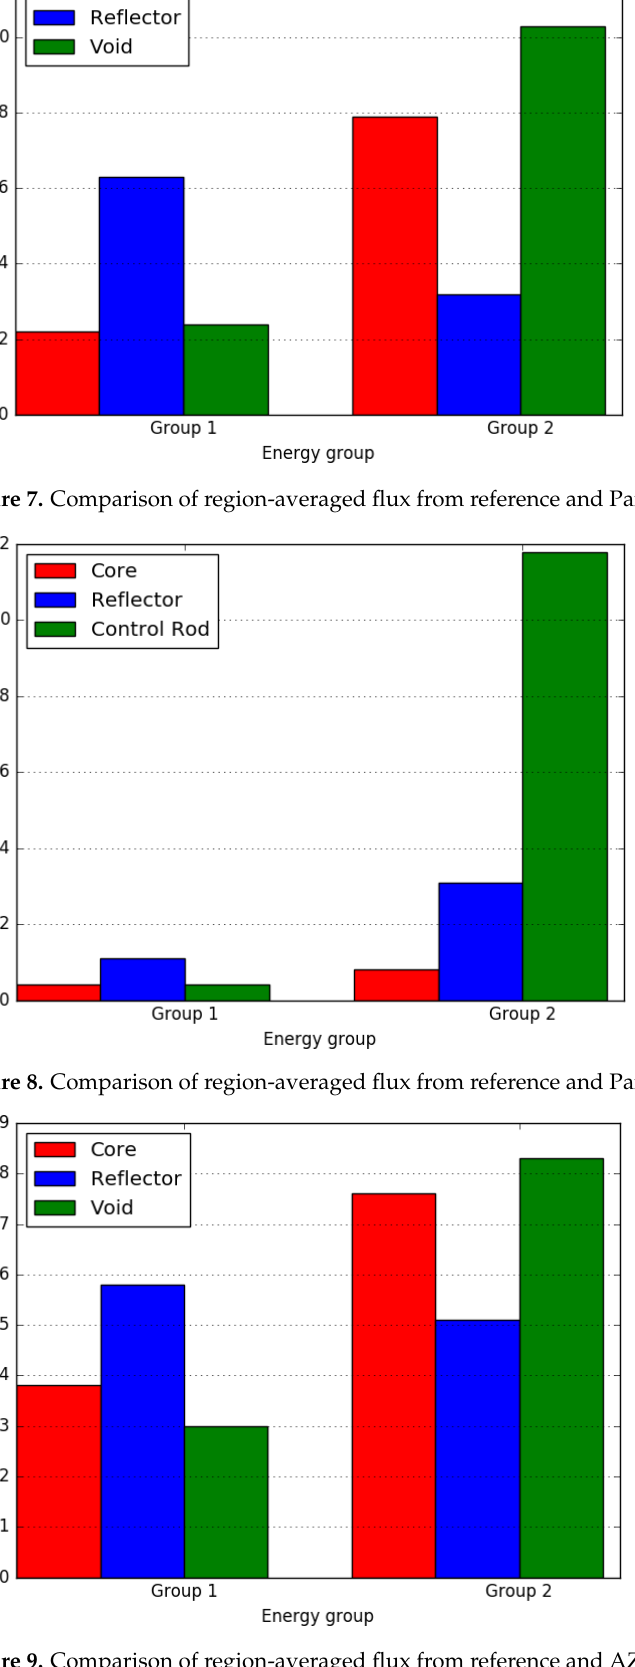
Figure 9. Comparison of region-averaged flux from reference and AZTRAN Model 1 Case